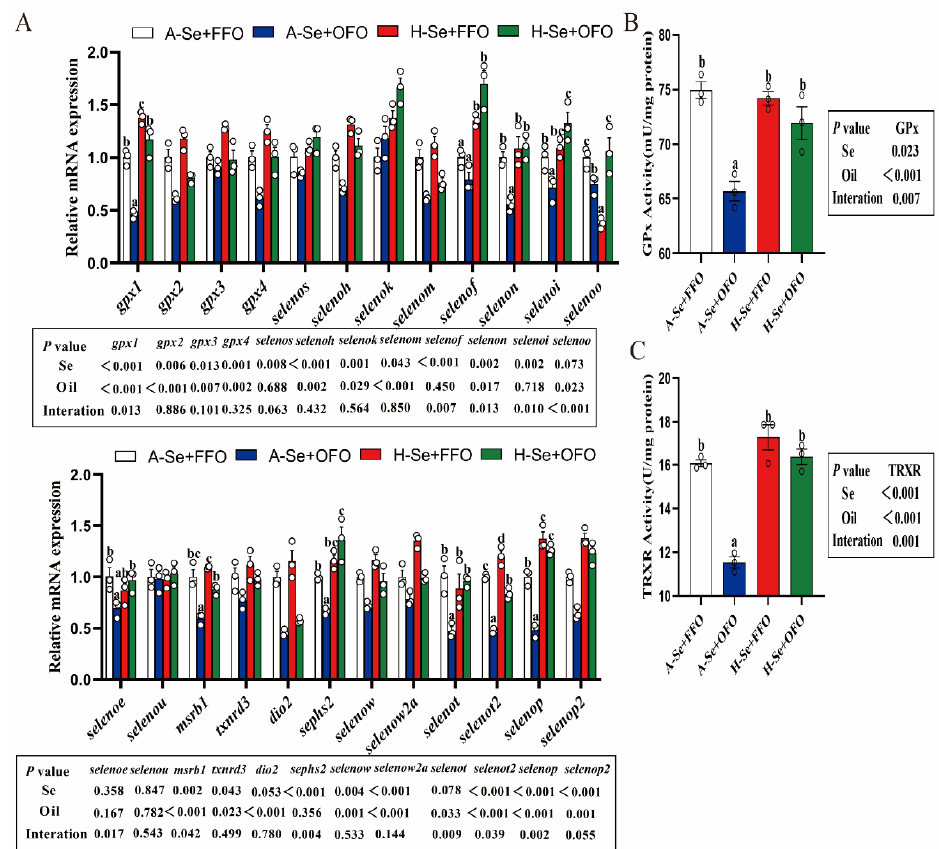
Figure 4. Effect of selenium and oxidized fish oils on selenoprotein expression in the intestine of yellow catfish. ( A ) The mRNA abundance of selenoprotein-related genes in the intestine. ( B ) GPx activity. ( C ) TRXR activity. All data were mean ± SEM ( n = 3). “a–c” indicate meaningfulness at p < 0.05. p value was calculated by two-way ANOVA. GPx, glutathione peroxidase; TRXR, thioredoxin reductase.